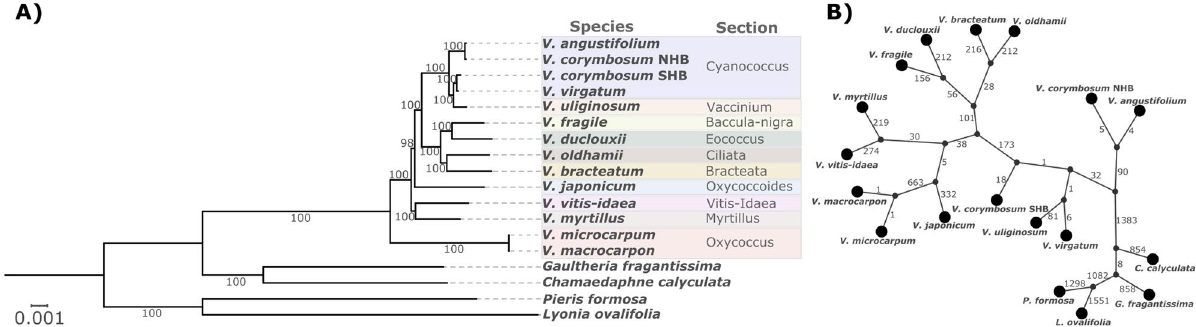
Figure 4. Phylogenetic and haplotype network analyses of whole chloroplast genomes of Vaccinium species. ( A ) Maximum likelihood phylogenetic tree. Different shades of colors represent different Vaccinium sections. Branch labels indicate the bootstrap support values. The scale bar represents nucleotide substitutions per site. Four taxa from different genera of the Vaccinioideae subfamily ( Chamaedaphne calyculata , Gaultheria fragantissima , Lyonia ovalifolia , and Pieris formosa ) were used as outgroups to root the tree. ( B ) Haplotype network showing the mutational steps separating the s pecies. Segment length is not proportional to the number of